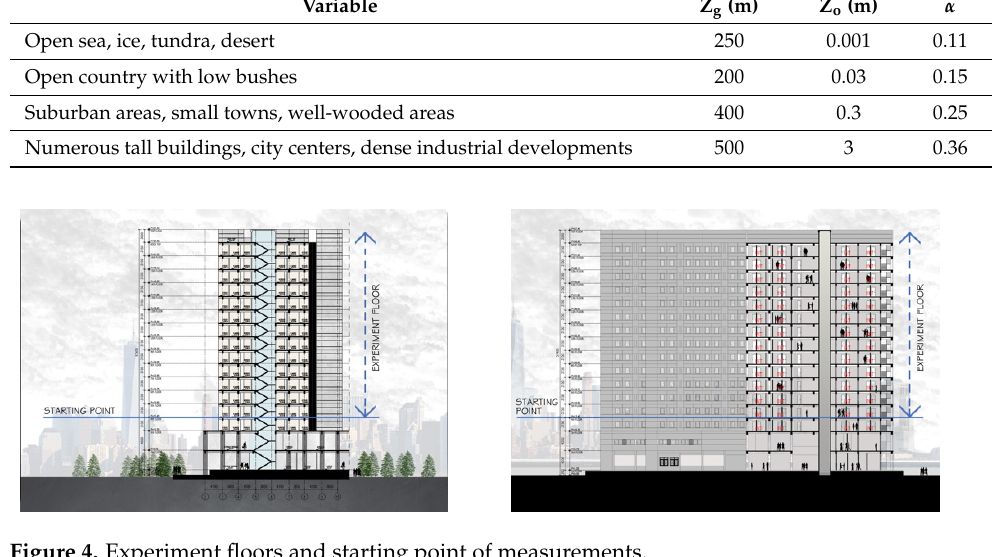
Figure 4. Experiment floors and starting point of measurements. Table 2. Research control variables. Table 1. Values for the roughness length [39].